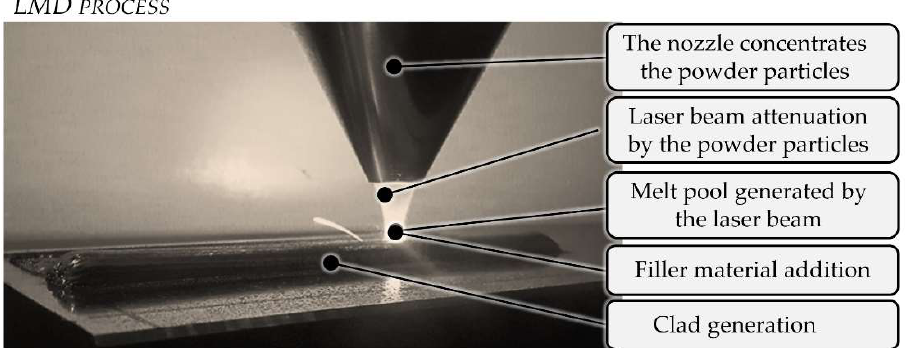
Figure 2. Basis of the Laser Metal Deposition (LMD) process.